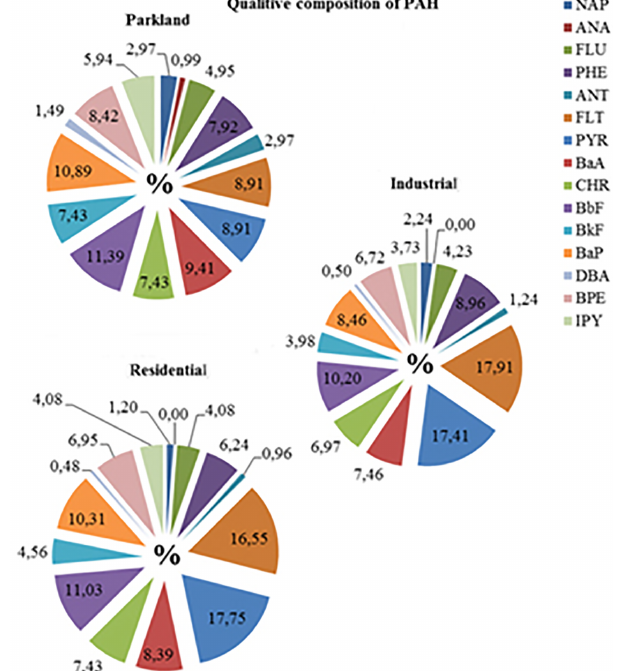
Figure 2. Composition of PAH mixtures in studied soil.